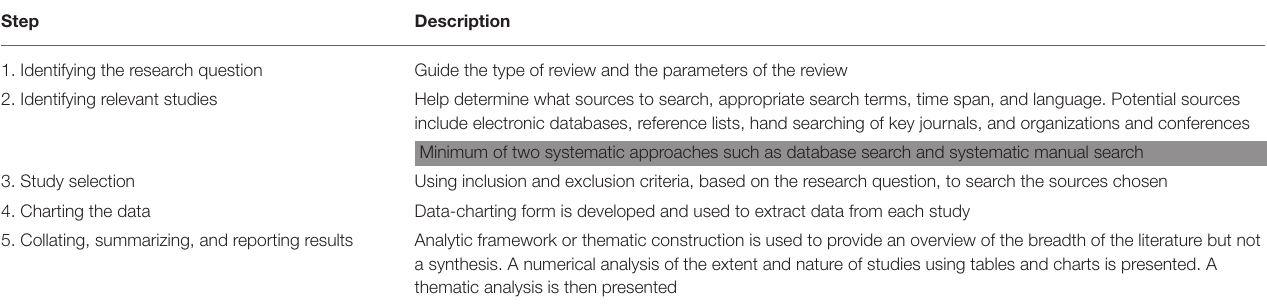
TABLE 1 | Scoping review framework (Adapted from Arksey and O’Malley, 2005).